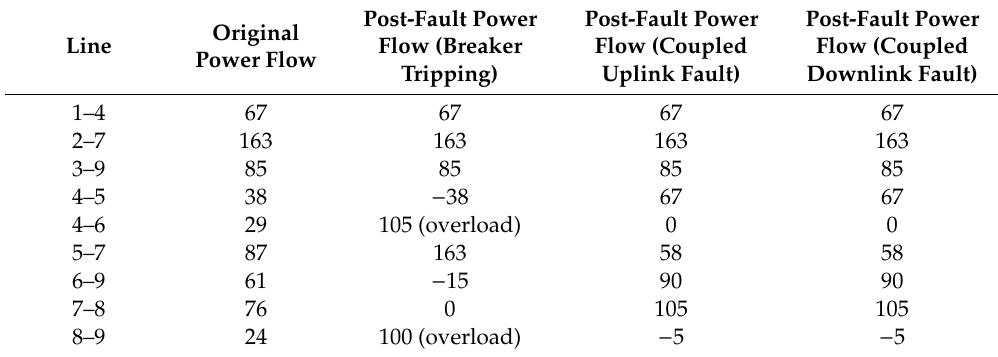
Table 4. The power flow transferring under coupled faults